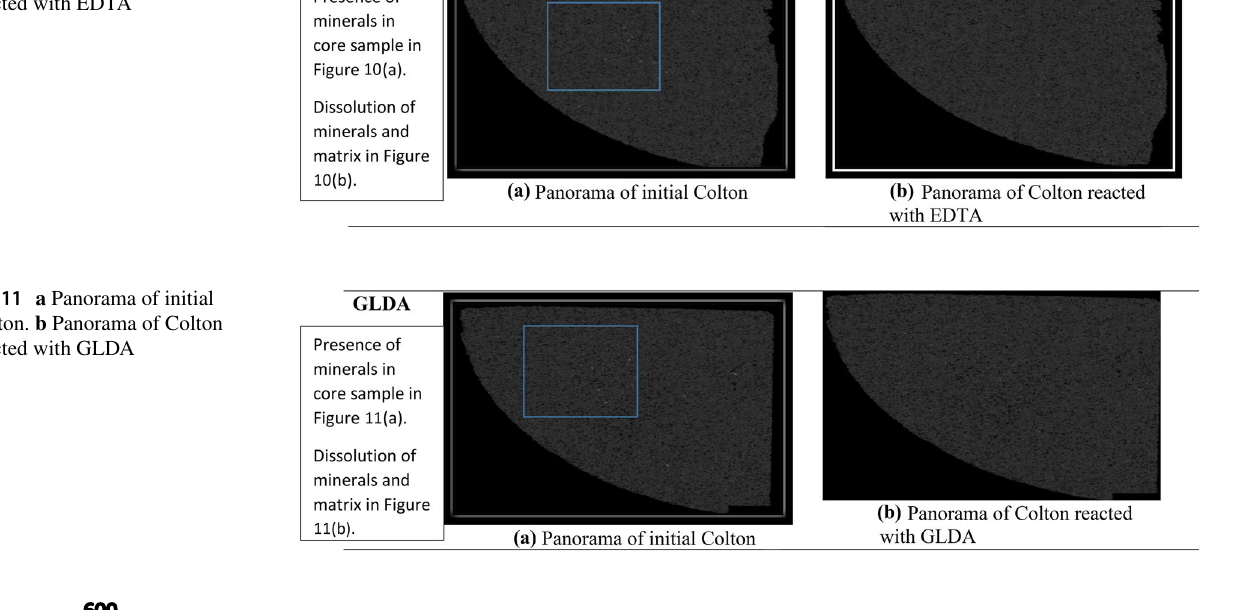
Fig. 10 a Panorama of initial Colton. b Panorama of Colton reacted with EDTA